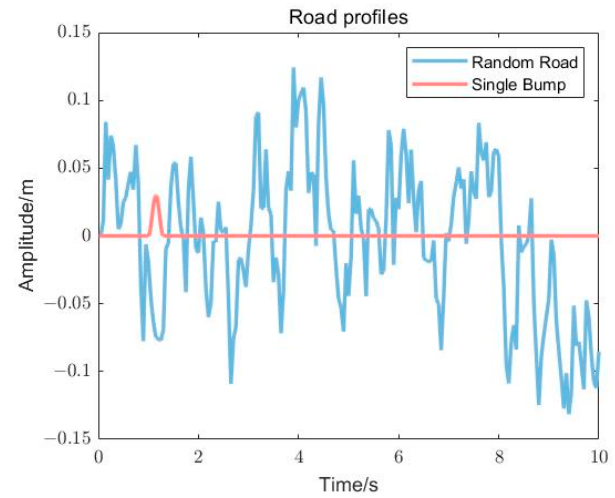
Figure 2. Two Types of Road Profiles.